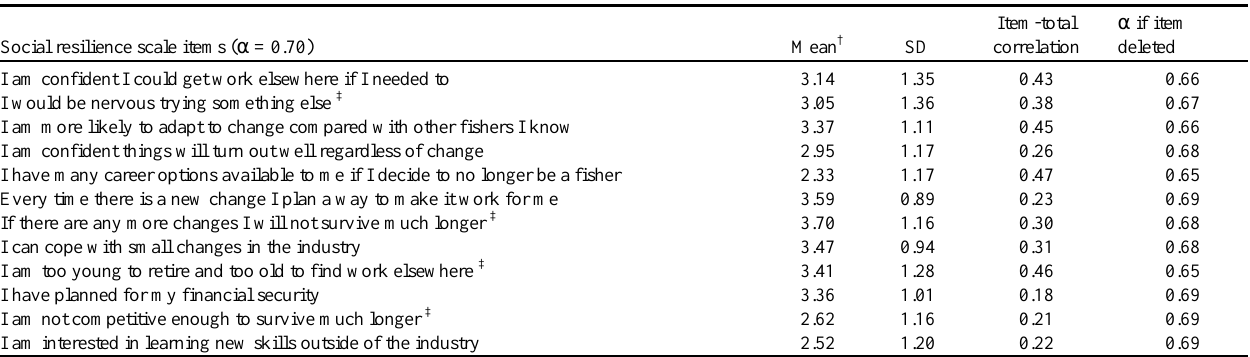
Table 1. Descriptive statistics and reliability analysis for the social resilience scale for Queensland commercial fishers Social resilience scale items ( a =